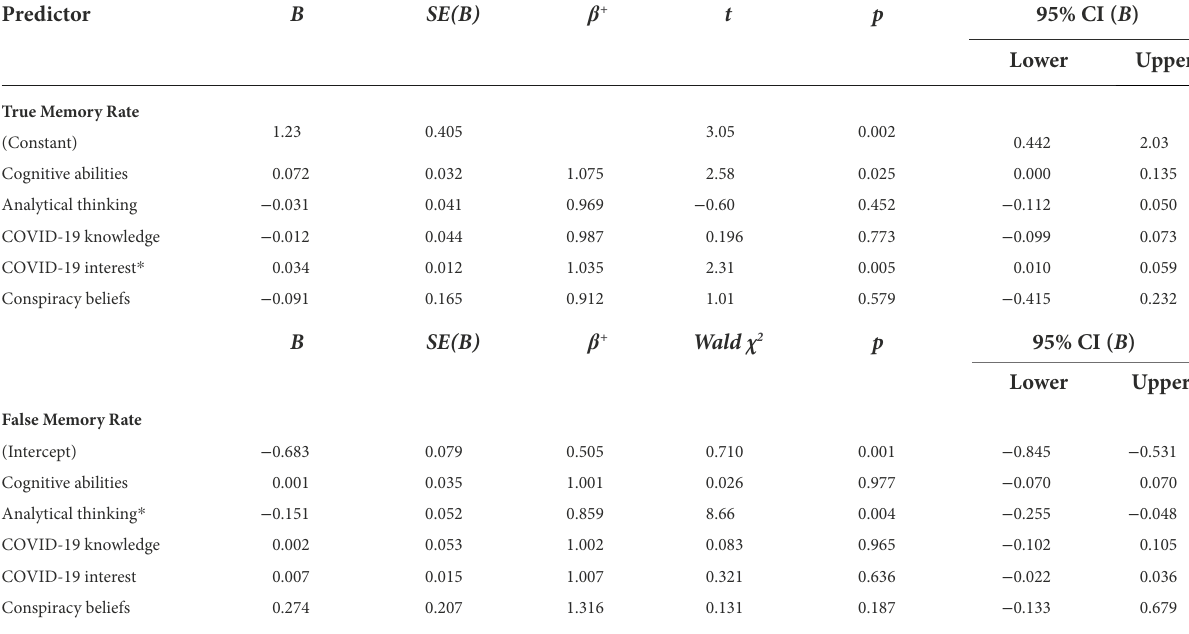
TABLE 4 Regression coefficients for predictors of vulnerability to COVID-19 news (Experiment